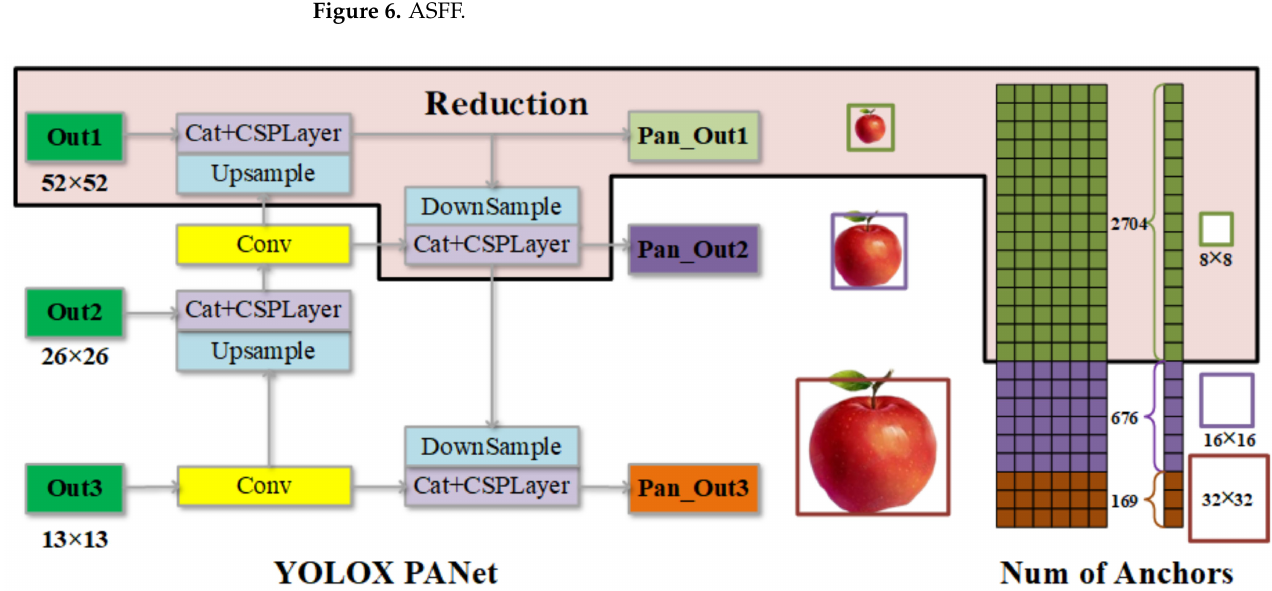
Figure 7. PANet with two feature